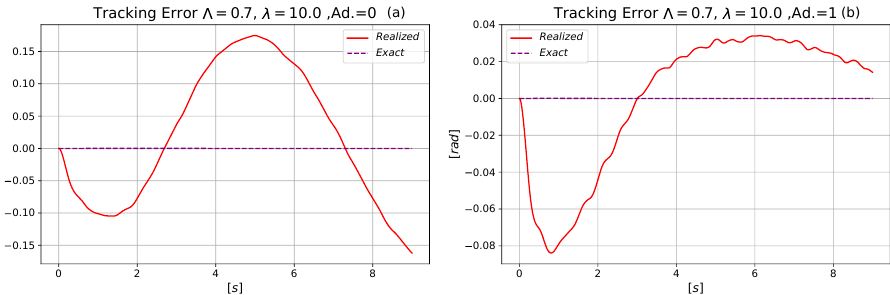
Figure 15. Trajectory tracking error for the small amplitude and circular frequency of the nominal trajectory. ( a ): Non-adaptive, ( b ): adaptive